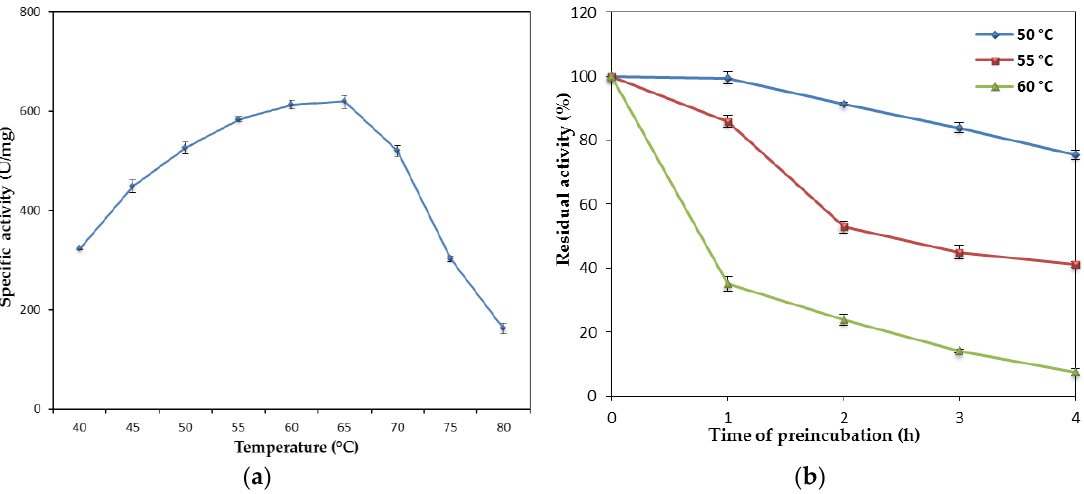
Figure 5. Effect of temperature on the mature rHZ lipase. ( a ) The optimum temperature of mature rHZ lipase. The enzyme was incubated with substrate (olive oil) at various temperatures for 30 min. ( b ) Effect of temperature on mature rHZ lipase stability. The rHZ lipase was pre-incubated at various temperatures ranging from 50 to 60 °C at 5 °C intervals for 4 h. The residual activity was measured at 65 °C (optimum temperature) every 1 h. Data are means ± standard deviations of three determinations ( n = 3) and the standard deviations are indicated as error bars.